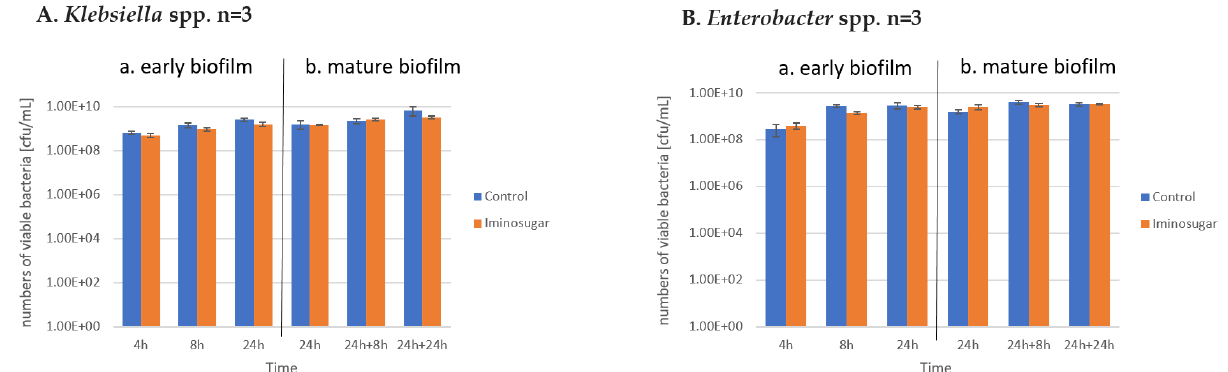
Figure 5. Effect of the tested iminosugar PDIA on numbers of viable population (n. refers to the number of strains) of selected Gram-negative Enterobacteriaceae ( A ) for Klebsiella spp. and ( B ) Enterobacter spp. in early ( a ) and mature ( b ) biofilm phase formation. Results depict logs of CFU/mL and measured at different time intervals. CFU, colony-forming units.